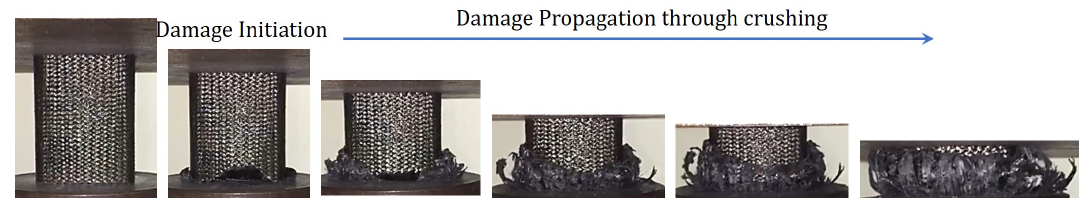
Figure 4. Crushing mode of the CFRP composite tube under different exposure temperature.